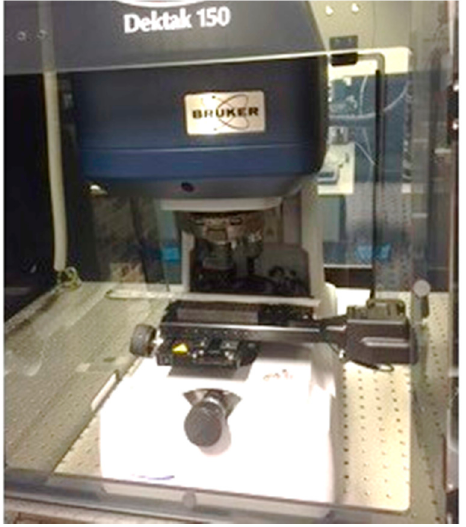
Figure 9. Laser profilometery of CFRP surface after failure analysis.